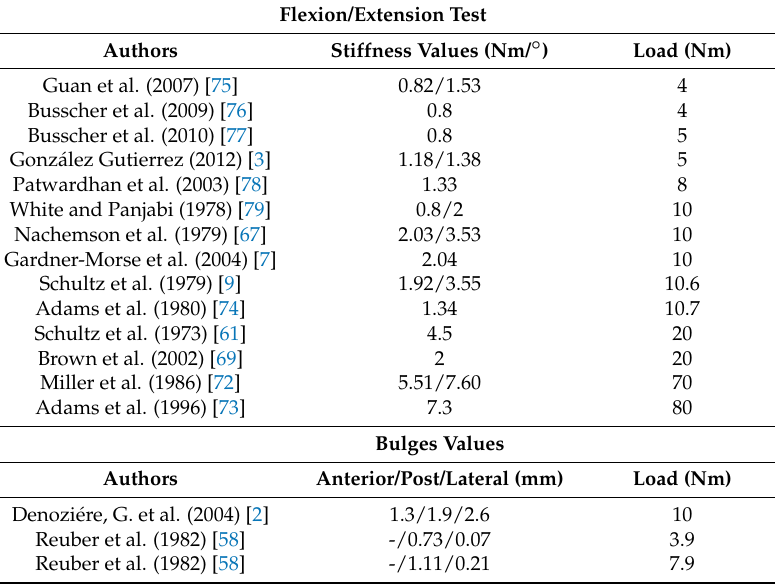
Table 3. Stiffness, bulge values, and flexion-extension loads from various authors.